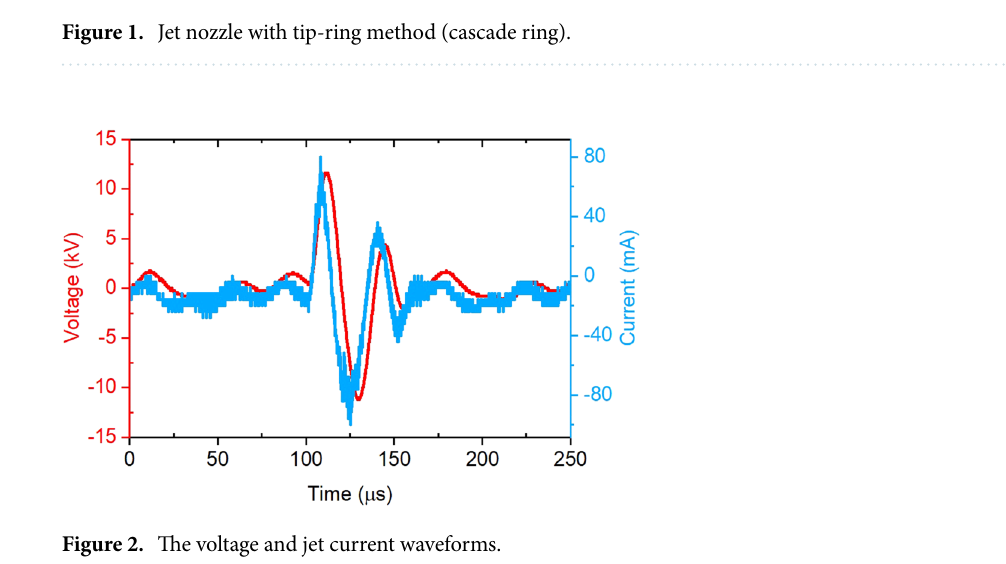
Figure 2. The voltage and jet current waveforms.